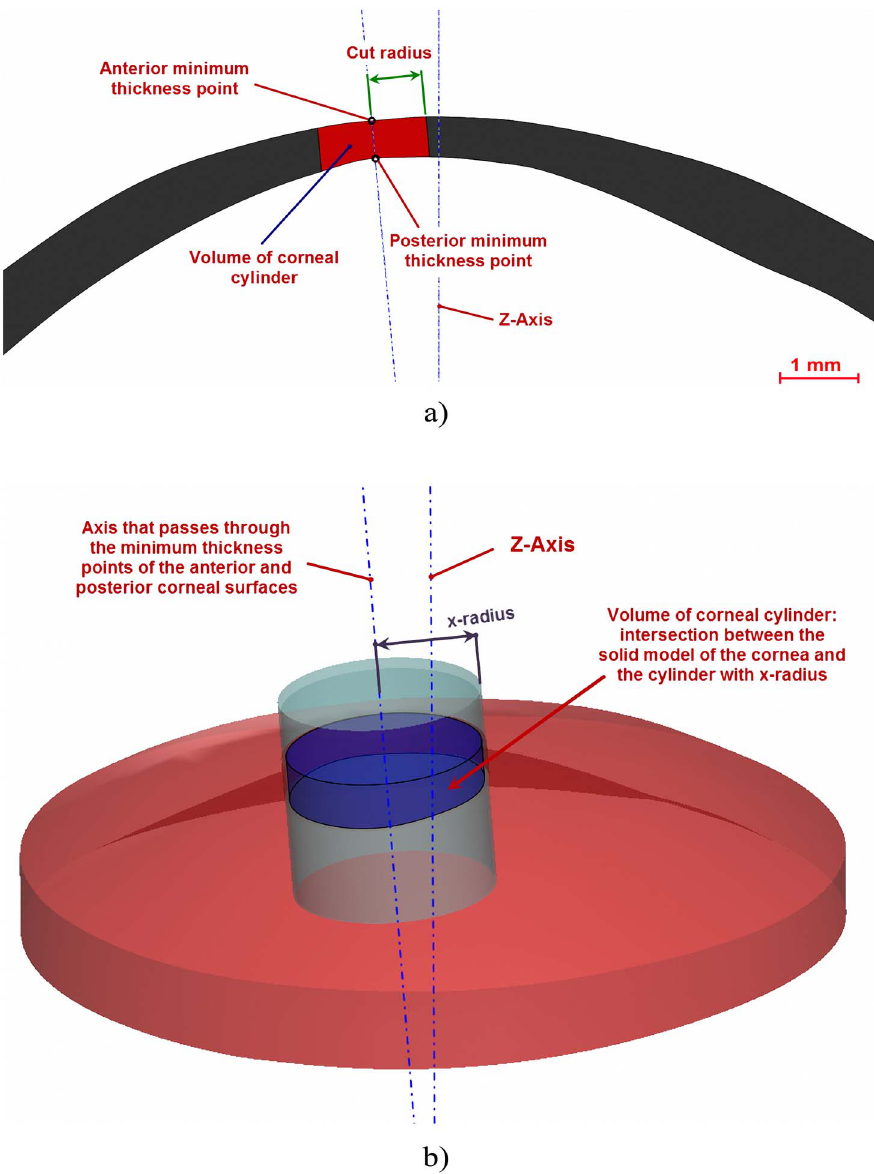
Figure 5. Volume of corneal cylinder with a determined radius: a) 2D view of the cylinder and its parameters, b) 3D view of the intersection between the solid model of the cornea and the cylinder.